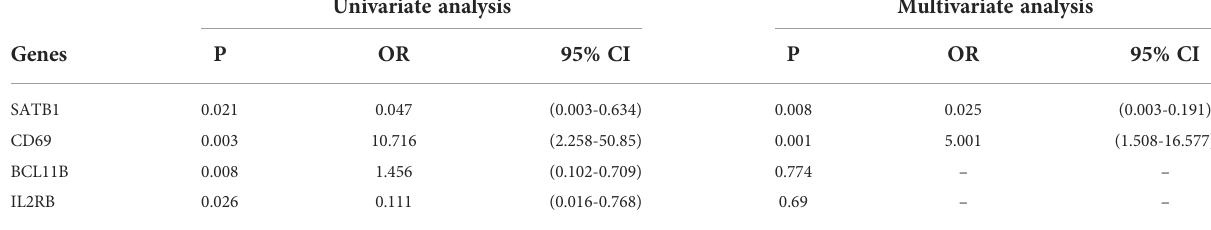
TABLE 1 Univariate and multivariate logistic regression for 4